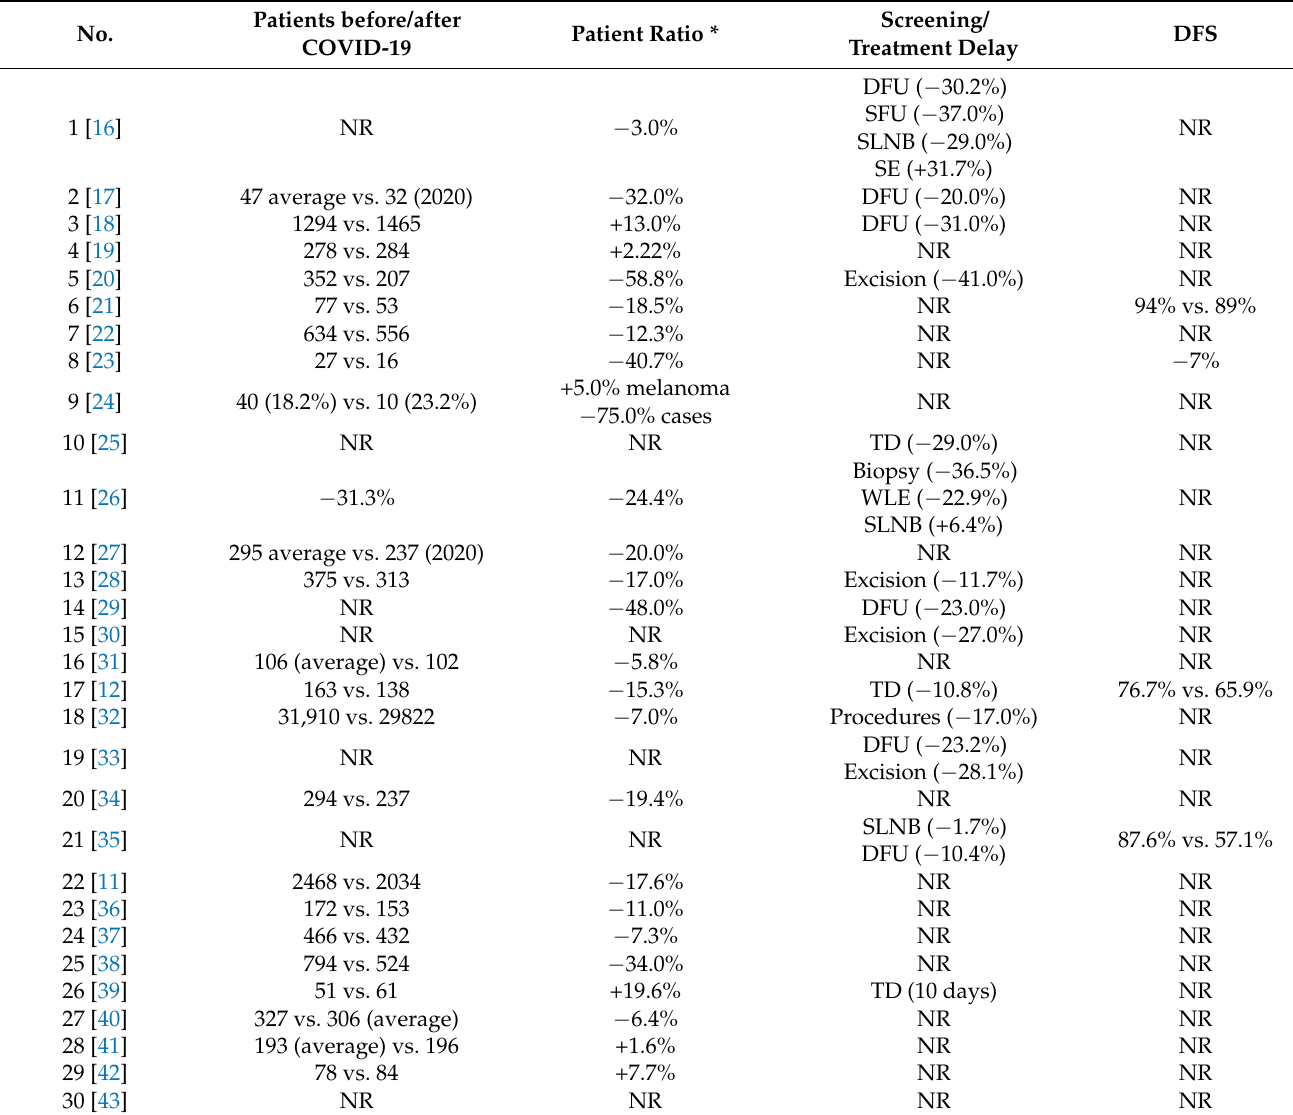
Table 3. Epidemiology data of malignant